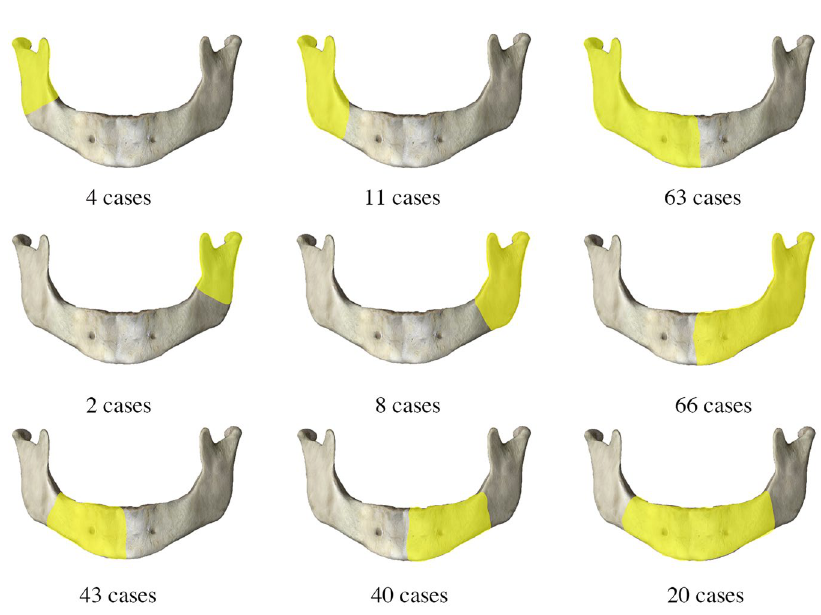
Figure 3. Distribution of lesion sites of